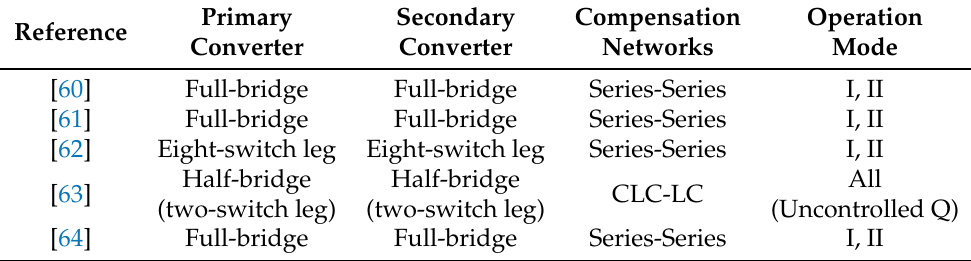
Table 1. Main features of V2G control based on the activation of the power